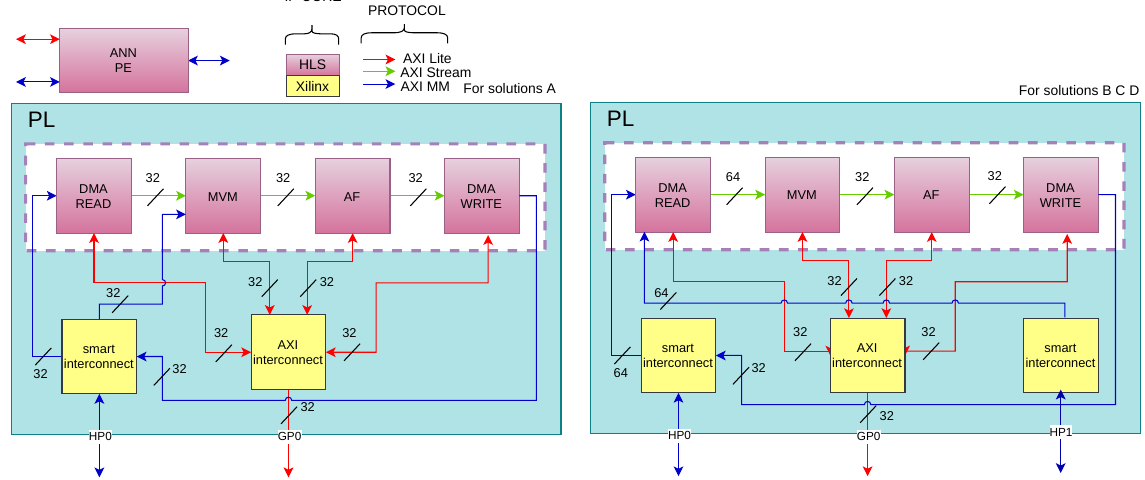
Figure 3. Artificial neural network processing element (ANN PE) in programable logic (PL)